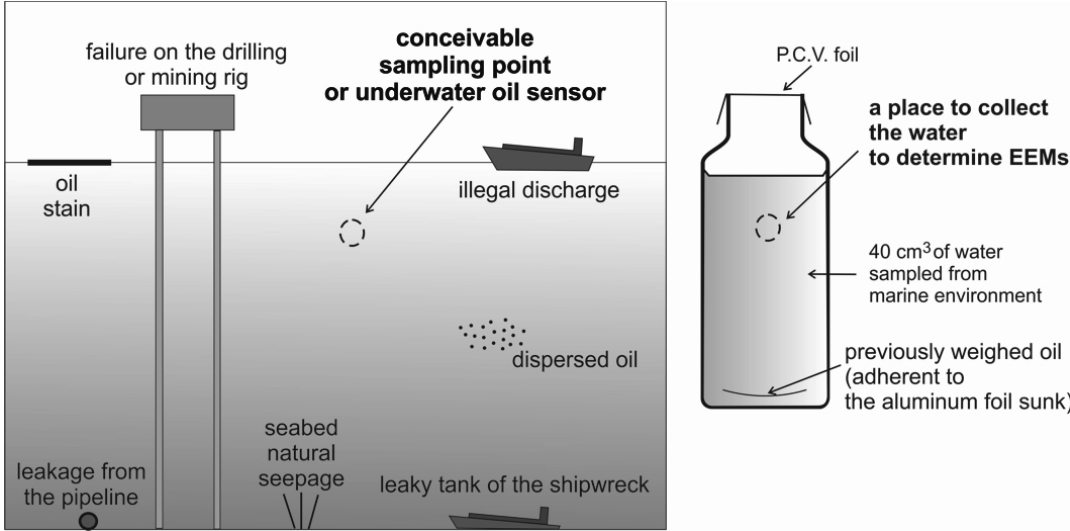
Figure 2. The possible situations of oil detection in the sea environment and principle of in-laboratory model realization.